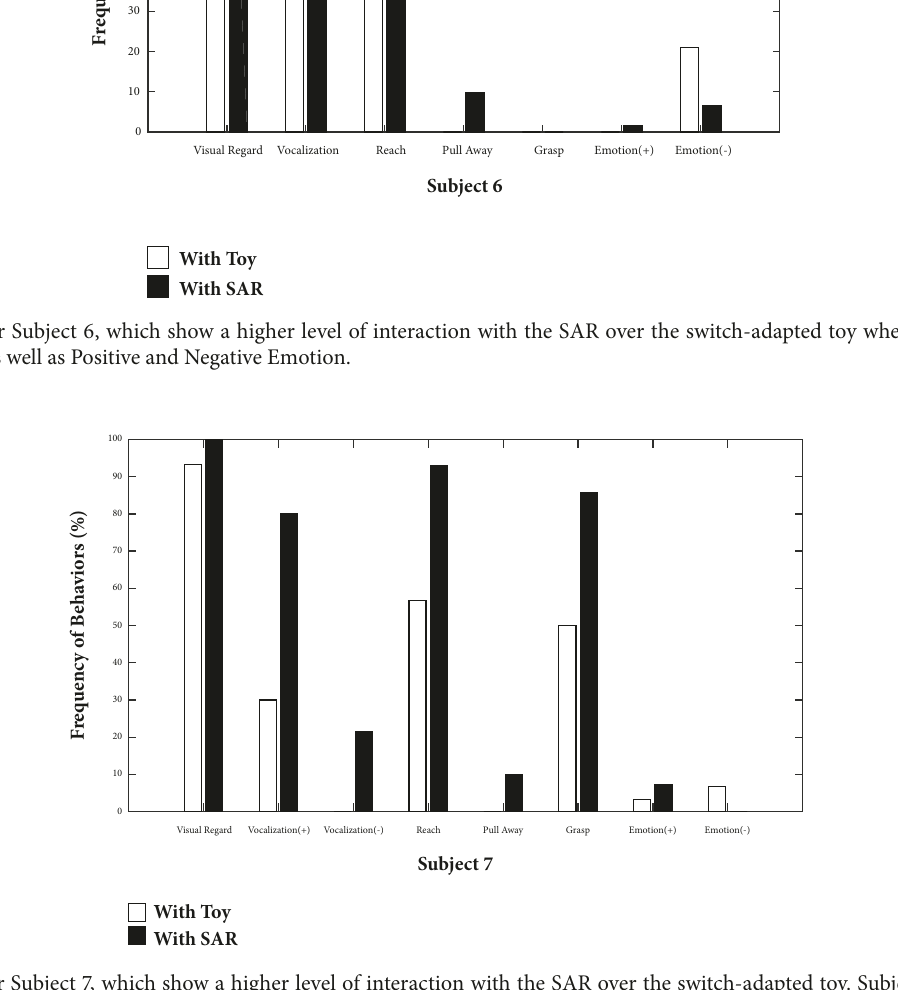
Figure 9: Results for Subject 7, which show a higher level of interaction with the SAR over the switch-adapted toy. Subject 7 was the only child capable of giving vocal commands, so a behavior for Negative Vocalizations was considered when the subject said “No!” or “Stop!” Even though this behavior was considered “negative,” subject-matter experts determined it showed a higher level of overall